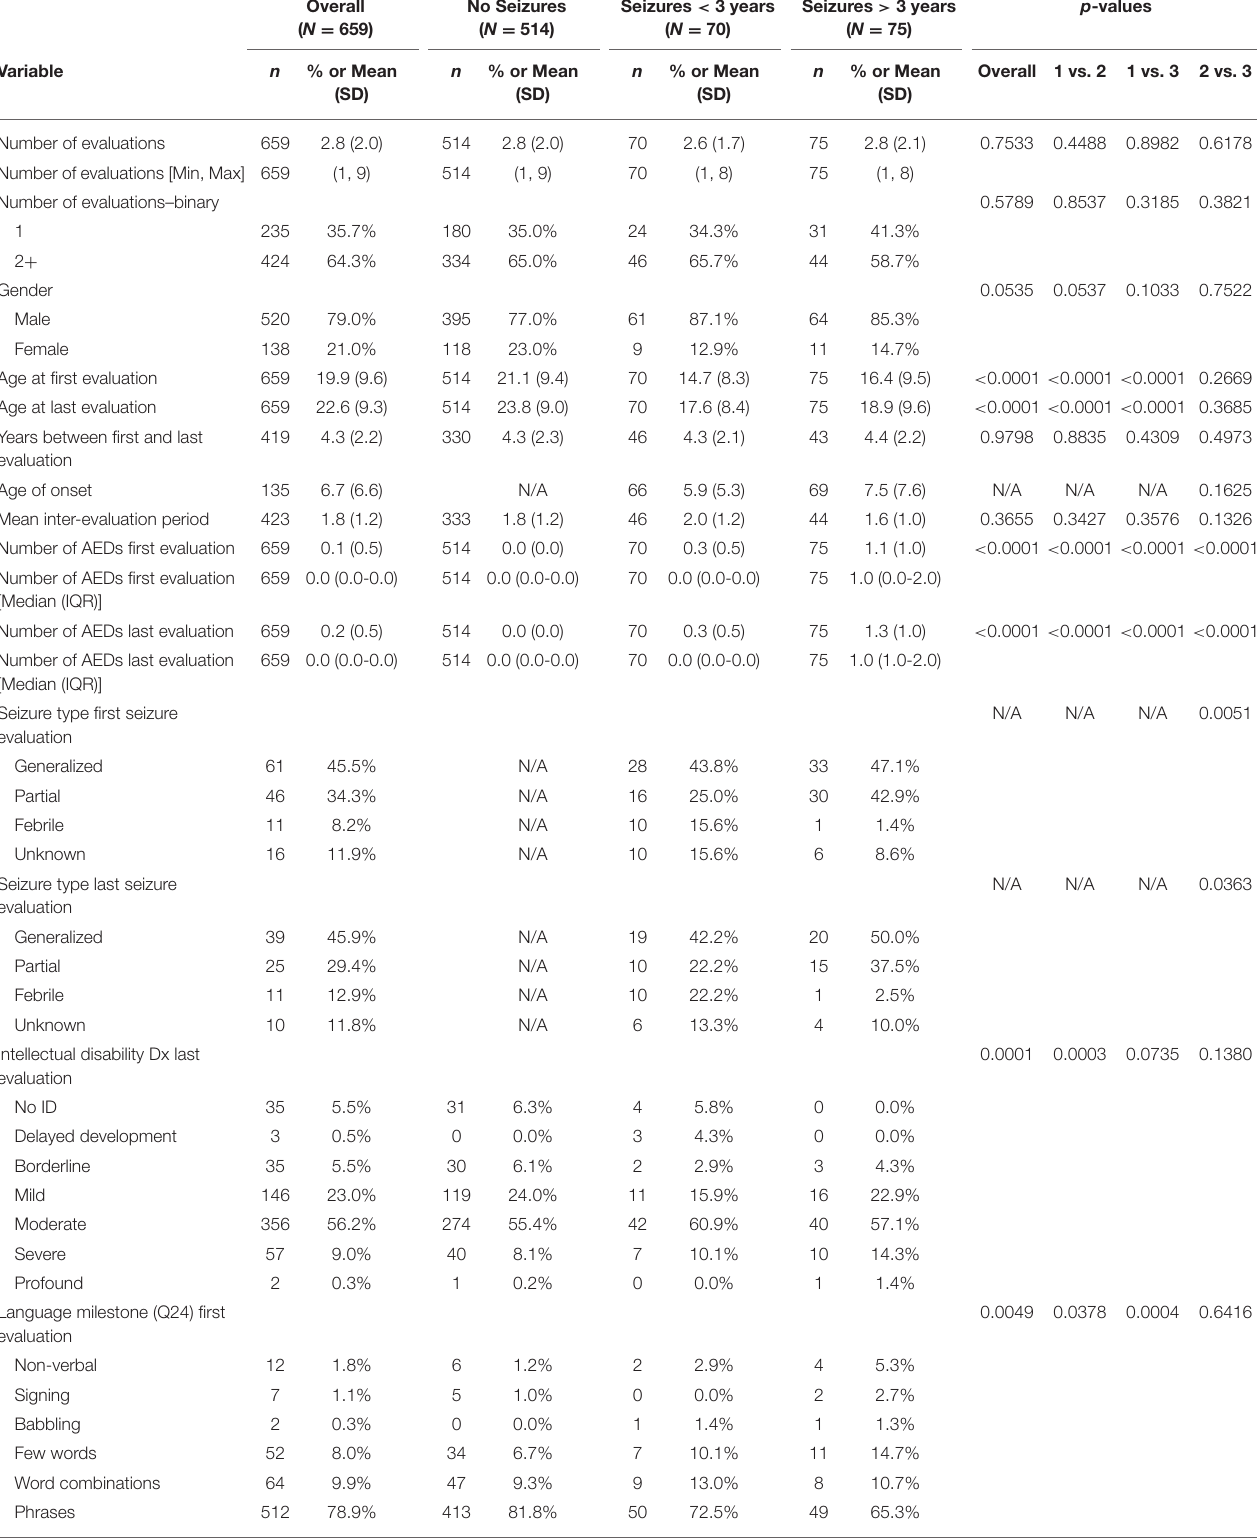
TABLE 4 | Comparison of characteristics between groups with no seizures, seizures reported for < 3 years, and seizures reported for > 3 years *